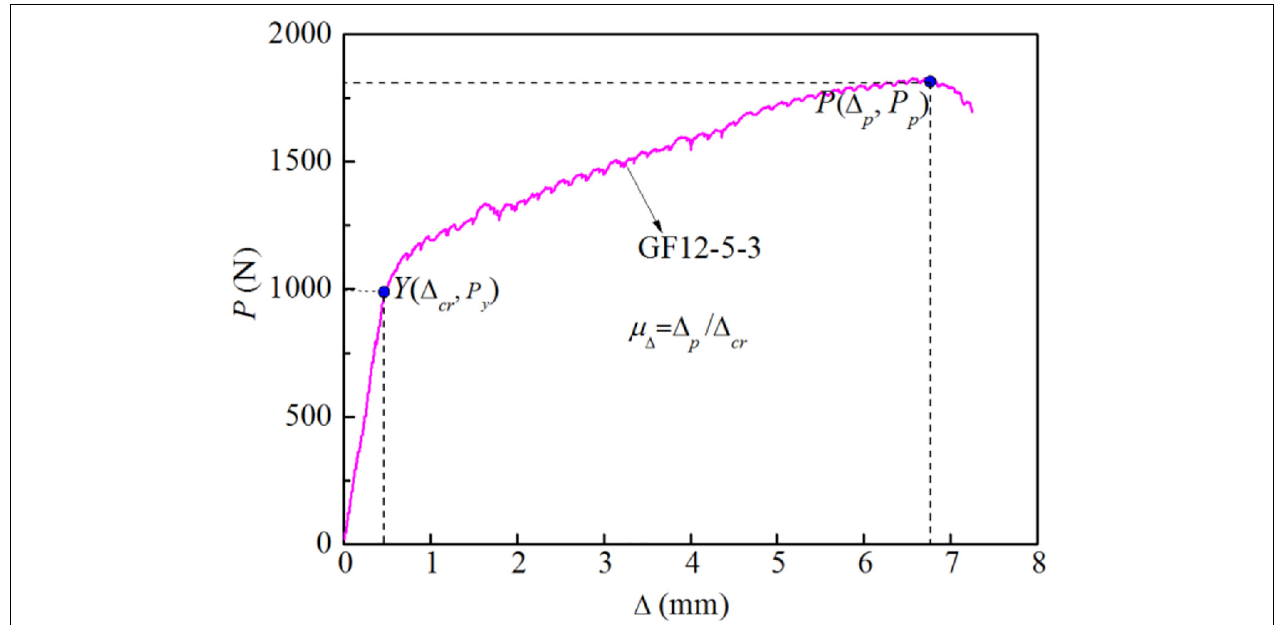
FIGURE 8 | Determination of displacement ductility coefficient for BTRC sheet.